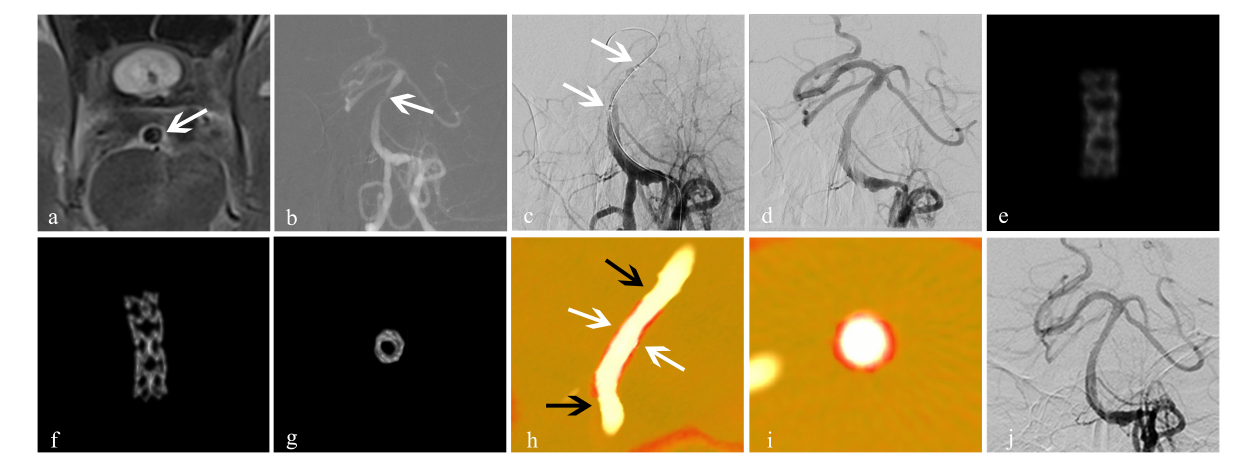
FIGURE 3 | Treatment for an atherosclerotic stenosis in the basilar artery with the ApolloTM stent. A 56-year-old man presented with dizziness of 2-week duration. (a) High-resolution MRI showed stenosis of the basal-artery trunk (white arrow); (b) 2D-DSA showed severe stenosis (80%) of the basilar-artery trunk (white arrow); (c) an Apollo balloon-expandable stent measuring 2.5 mm × 8 mm was placed (white arrow); (d) DSA showed improved blood flow with good expansion of the stent, and residual stenosis was 5%; (e) conventional FDCT showed the blurred metal struts of the stent with an image-quality score of 0; (f,g) HR-FDCT showed that the stent struts were clear and expanded completely, and image quality was improved significantly with a score of 2; (h,i) Dual volume three-dimensional fusion images showed good apposition of the stent to the vessel wall (stent, white arrow; vessel wall, black arrow); (j) follow-up DSA at 6 months showed durable stent patency. Panels (e–g) were obtained in vivo .